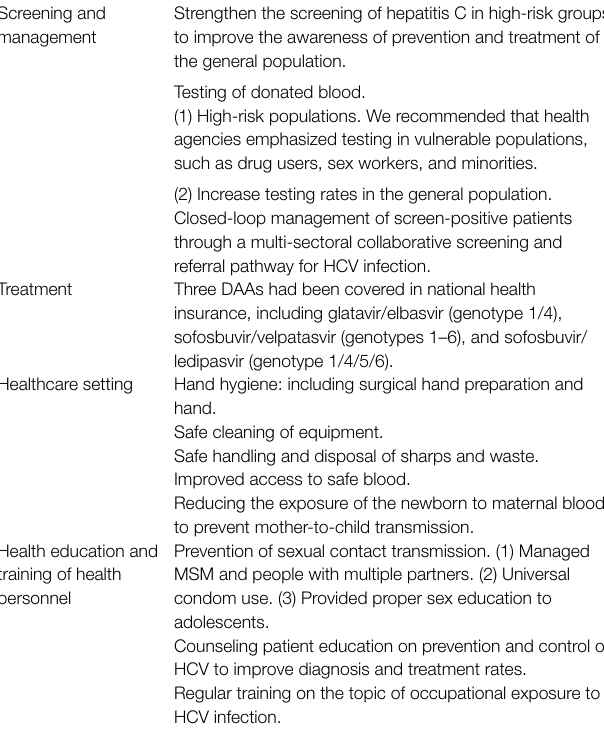
TABLE 1 | Recommendations to further reduce the burden of hepatitis C in